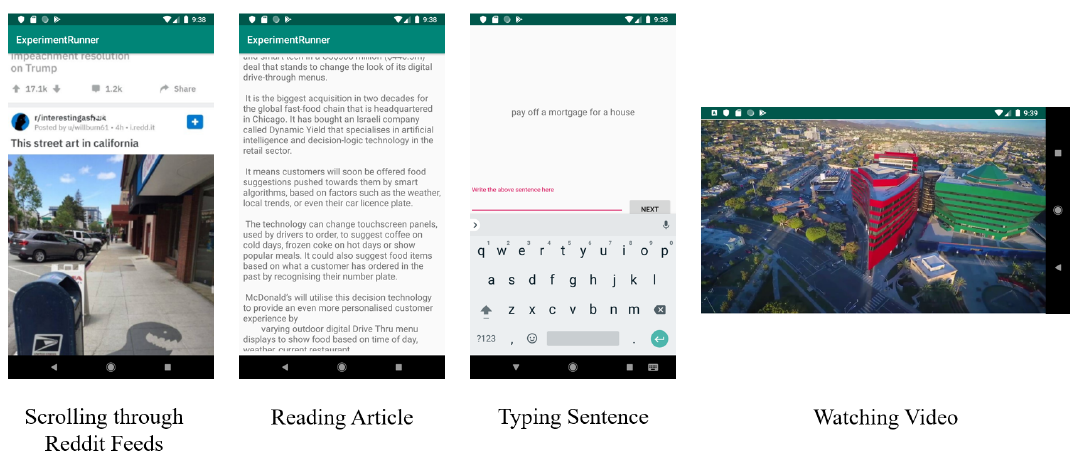
Figure 4. Screenshots of the four tasks which participants completed as part of the study, while software collects the IMU sensor data. Each of the four tasks is completed while sitting and while